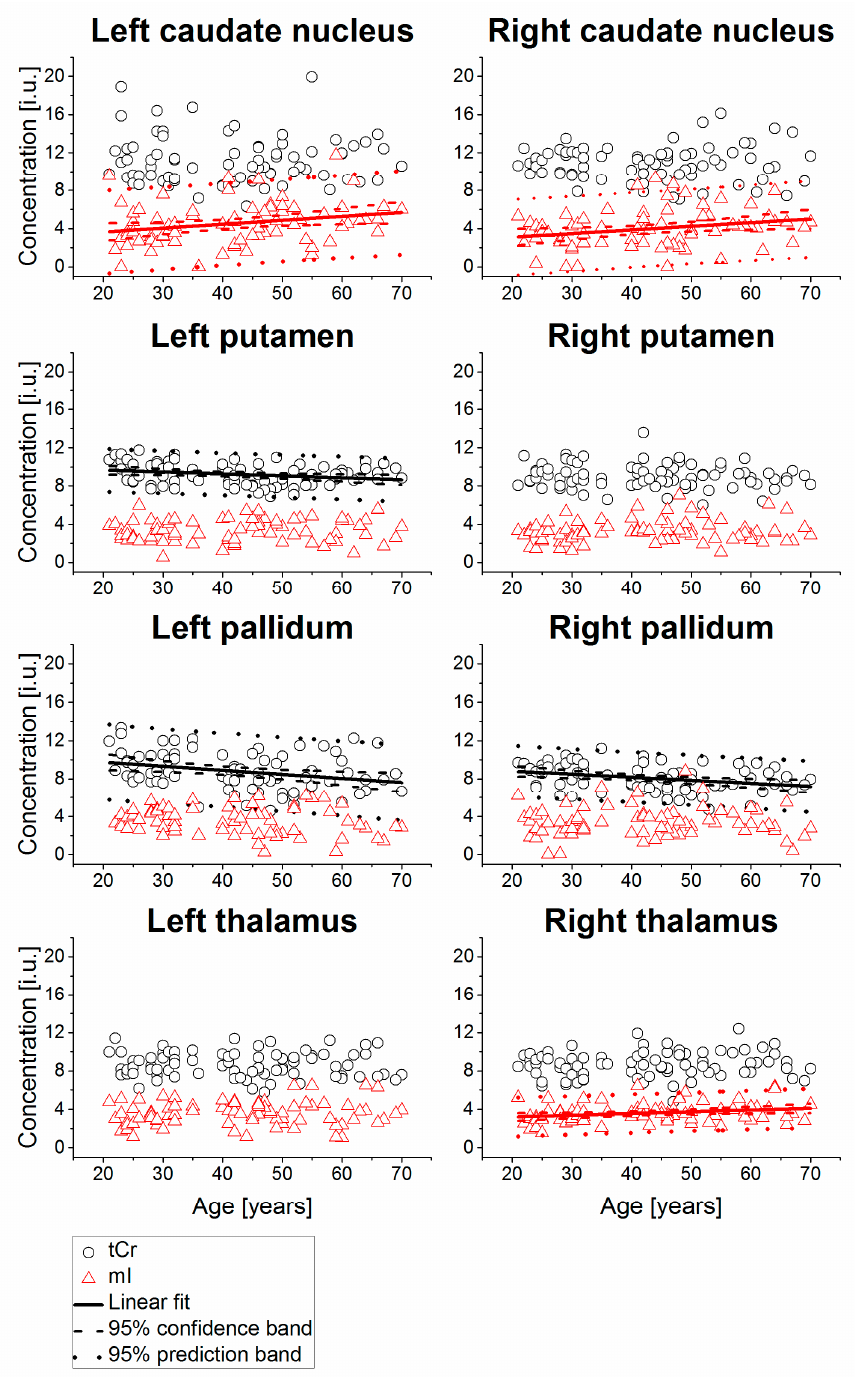
Figure 4. Relative concentrations of tCr and mI from bilateral caudate nucleus, putamen, pallidum, and thalamus, shown as a function of age, including linear fits with 95% prediction interval and 95% confidence interval for statistically significant cases ( p < 0.05). The values are presented in institutional unit (i.u.) normalized using the signal from tissue water.